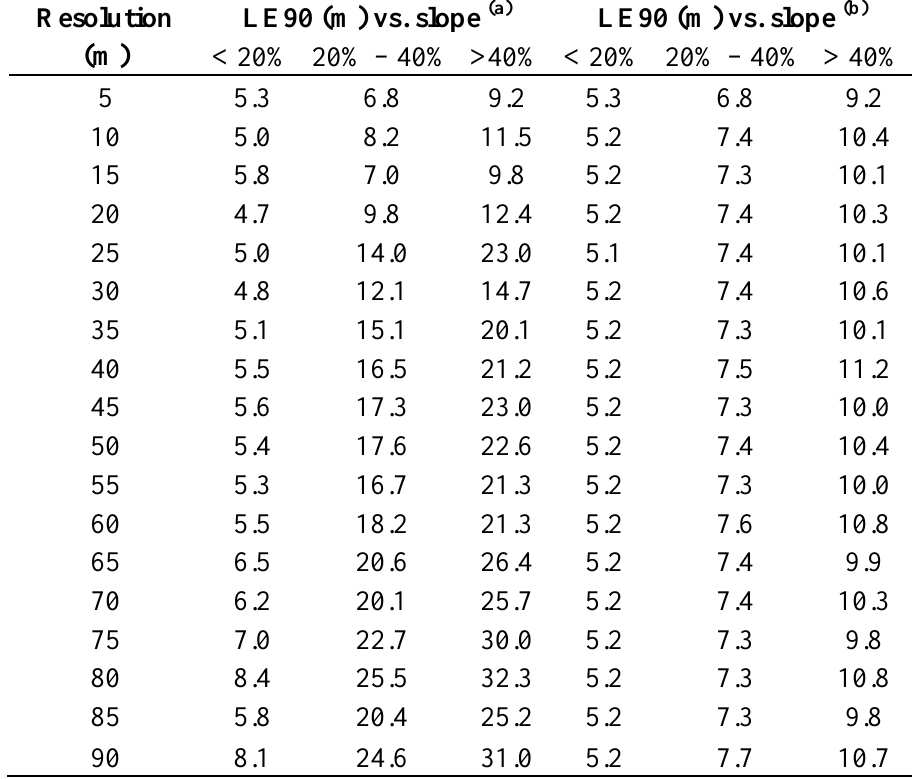
Table 2. Summary of residuals vs. slope for Cartosat-1 DSMs generated over Salon de Provence test site. (a) for DSMs generated at the desired resolution directly from the Cartosat-1 images. (b) for DSMs generated by downsampling the 5m resolution Cartosat-1 DSM. All values refer to a comparison over the whole test